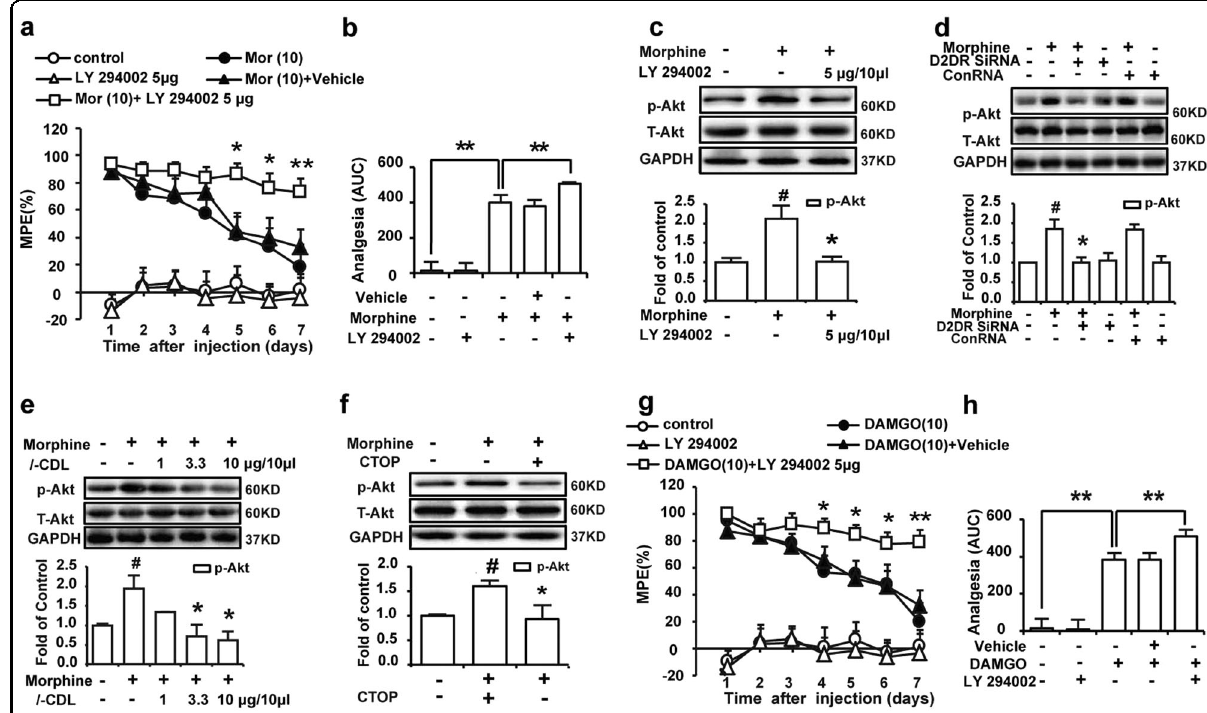
Fig. 5 l- CDL antagonizes spinal D2DR to attenuate morphine tolerance in mice by inhibiting PI3K/Akt signaling in a MOR-dependent manner. a , b Intrathecal administration of the PI3K inhibitor LY 294002 (5 μ g/10 μ l) attenuated morphine tolerance, while LY 294002 (5 μ g/10 μ l) alone did not affect the pain threshold of naïve mice. The analgesia was further reported as area under the curve (AUC) units. Data are presented as means ± SE. n = 12, * P < 0.05, ** P < 0.01, compared with the morphine group. c Intrathecal administration of LY 294002 (5 μ g/10 μ l) reduced the increase in p-Akt levels in the spinal cord. d , e Intrathecal administration of the D2DR siRNA and l -CDL reduce p-Akt levels in the spinal cord, while intrathecal administration of the D2DR conRNA had no effect. f Intrathecal administration of the MOR antagonist CTOP (1 ng/10 μ l) reversed the increased p-Akt levels in the spinal cord. Data are presented as means ± SE. n = 4, # P < 0.05, ## P < 0.01, compared with the control group; * P < 0.05, ** P < 0.01, compared with the morphine group. g , h Intrathecal administration of the PI3K inhibitor LY 294002 attenuated DAMGO-induced tolerance. All spinal cords were collected on day 7, 30 min after chronic morphine exposure. Data are presented as means ± SE. n = 12, * P < 0.05, ** P < 0.01, compared with the DAMGO